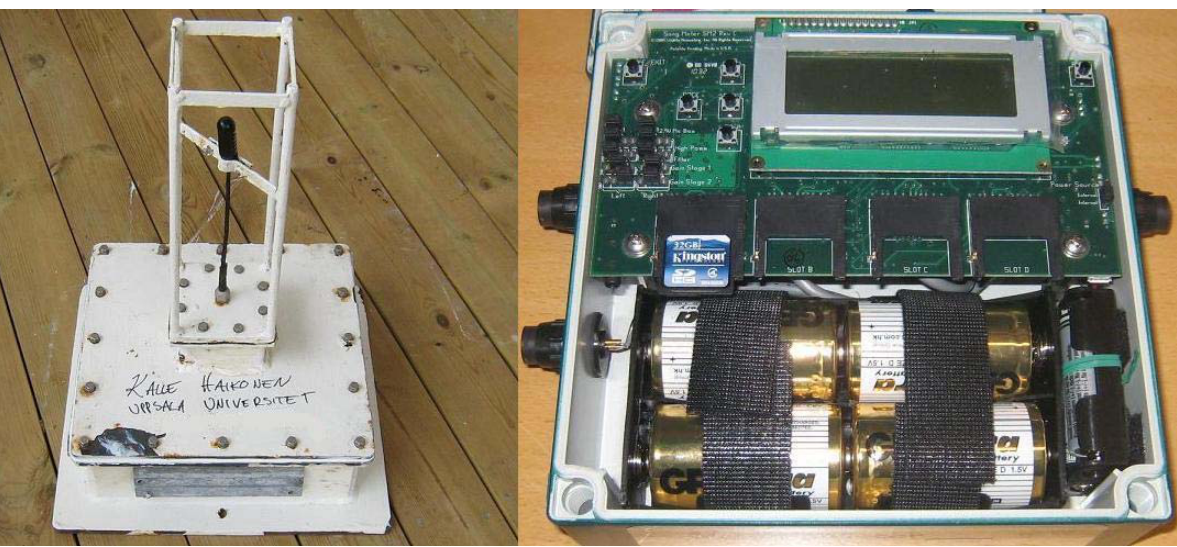
Figure 4. To the left is the underwater housing for the data recorder, the hydrophone is suspended 40 cm above the surface on which it is deployed. To the right is the data recorder